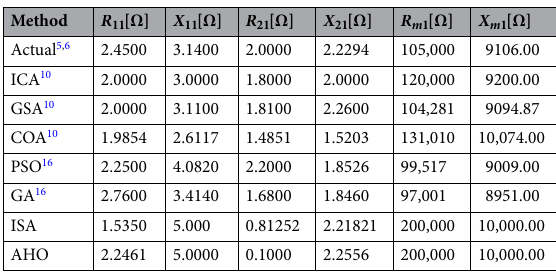
Table 1. Estimated parameter for the 15 kVA transformer.